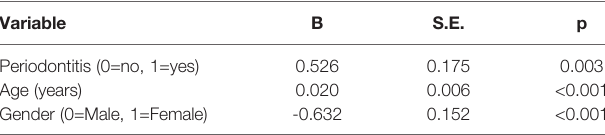
B, Unstandardized beta; S.E., Standard error of unstandardized beta.